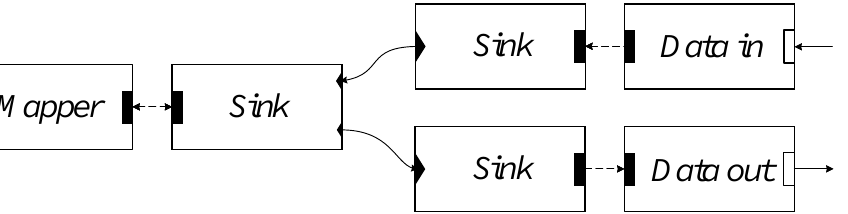
Figure 3. The different types of adapters in a sample configuration. The central adapter is the Mapper. This is a processing adapter that forwards data from input adapters to processing adapters and to output